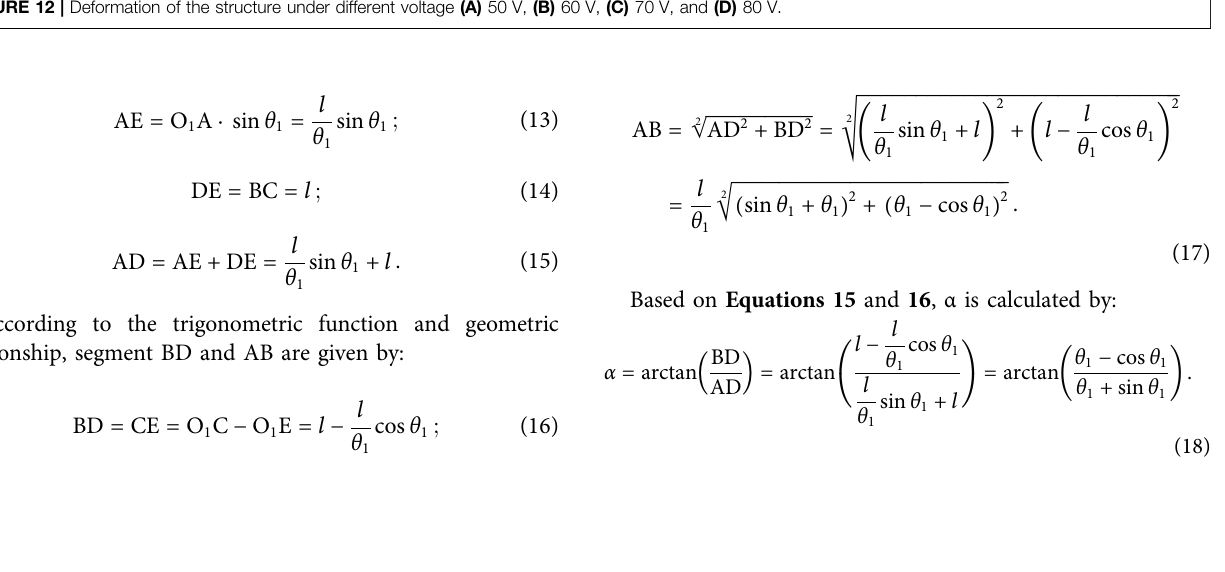
FIGURE 12 | Deformation of the structure under different voltage (A) 50 V, (B) 60 V, (C) 70 V, and (D) 80 V.